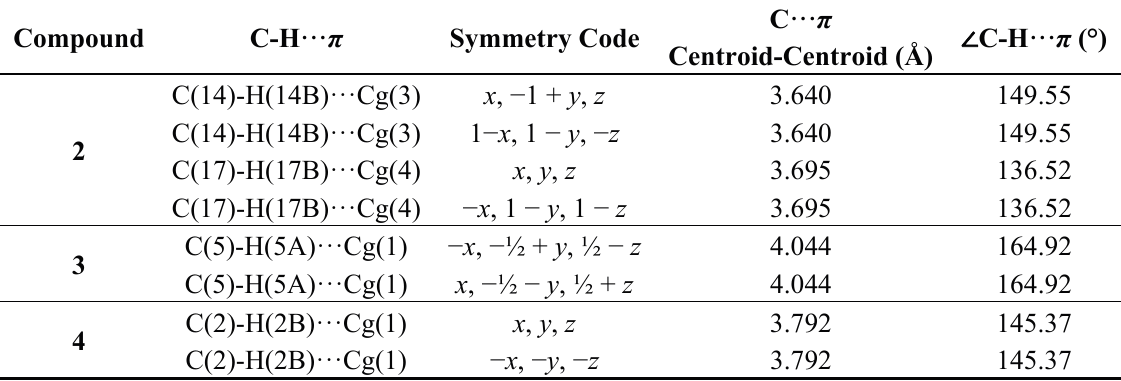
Figure 2. ( A ) Molecular structure of 2 with atomic numbering, ( B ) 1D-R right-handed zigzag chain shown as green-red, ( C ) 3D supramolcular architecture of 2 constructed by water chains and two different symmetry equivalent anion-cation groups and ( D ) 1D-L left-handed zigzag chain shown as blue-yellow. Table 1. Selected C-H··· π Interactions in Compounds 2 , 3 and 4